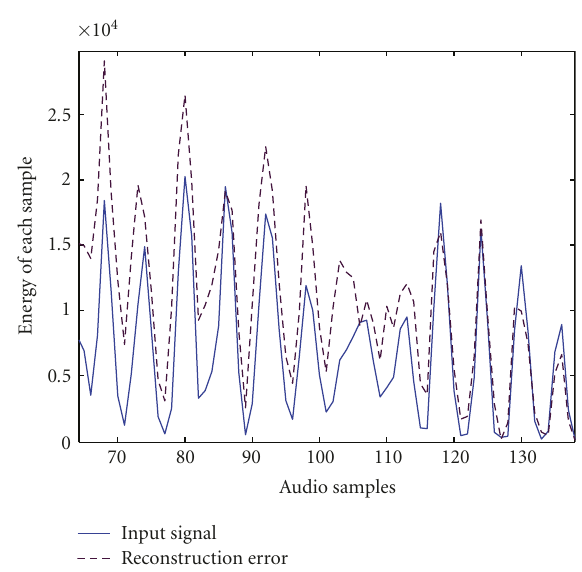
Figure 3: Illustration of the cause of the scalability